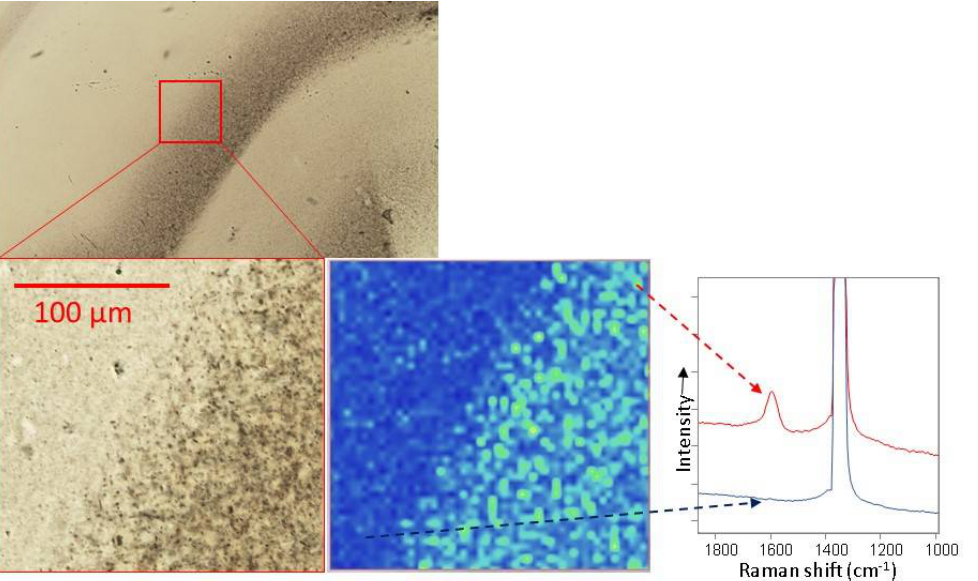
Figure 6. Raman mapping of a cubo-octahedral diamond plate from the Marange deposit in Zimbabwe, which often shows regions of grayish clouds. The image and Raman map are looking at the boundary between colorless and included regions, studying the graphite-related Raman feature at a Raman shift of 1600 cm −1 . This room-temperature Raman map is composed of 2968 individual spectra with 5 µm pixel size and took 4.5 h to complete using 532 nm excitation.